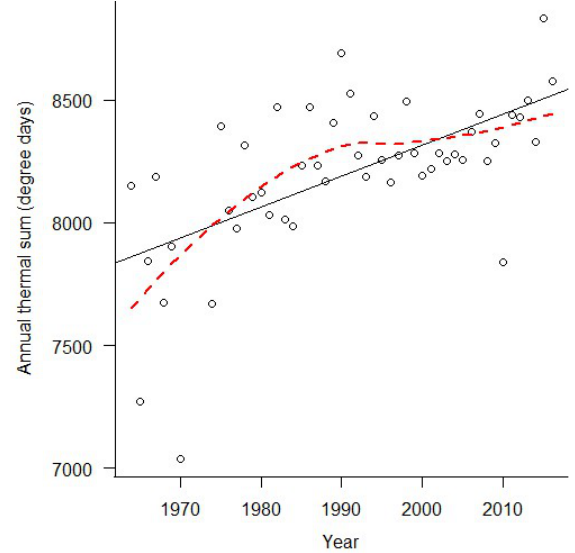
Figure 2. Long-term thermal sum trend. The total amount of heat experienced by organisms in Central Florida is increasing over time. The thermal sum (in degree days, °Cd) was calculated by totaling the mean temperature for each day within each year, and a best-fit line was added (solid black) using simple linear regression. The red dotted line was added using locally estimated scatterplot smoothing (LOESS) with a span of 1 for visualization purposes.